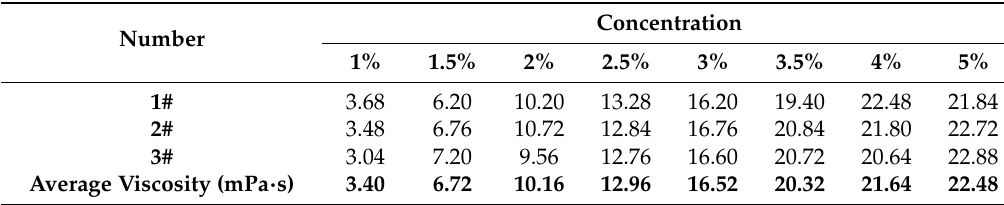
Table 4. Viscosities of sodium dodecyl sulfonate-soybean protein isolate (SDS-SPI) cementing dust suppressant solutions.